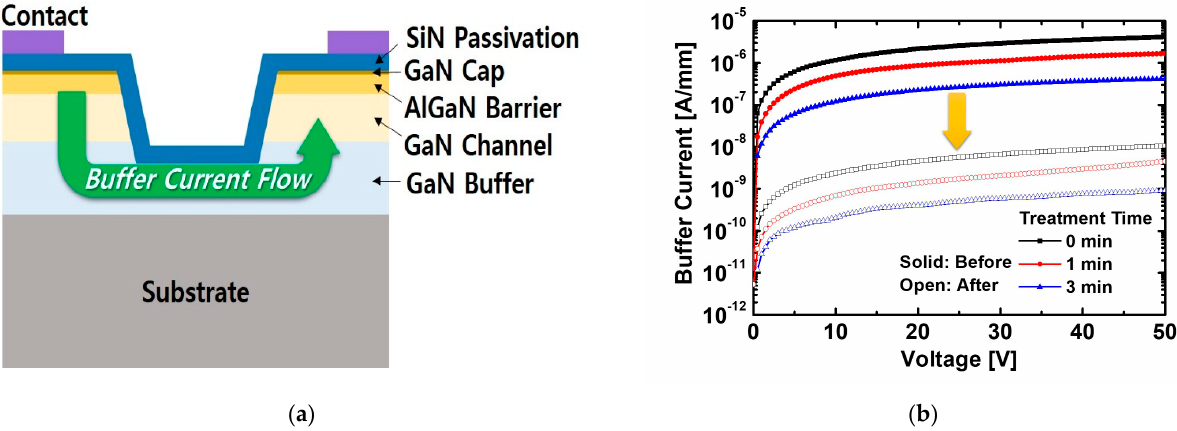
Figure 5. ( a ) Schematic structure for measurement of the buffer current. ( b ) Buffer current characteristics of the structure with and without treatment for 1 and 3 min before and after the proton irradiation.